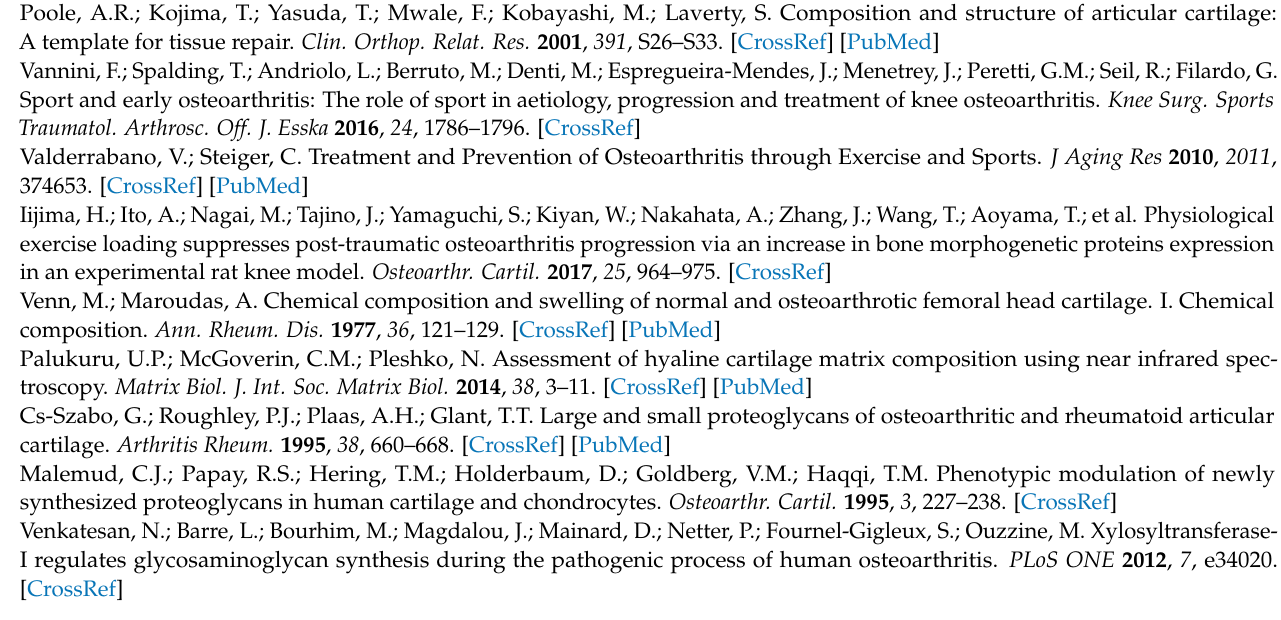
Table S2: Expression of selected genes related to heparan sulfate synthesis in WT and Ext1 gt/gt - engineered cartilage according to cDNA array analysis, Table S3: Expression of genes regulated >1.5-fold in WT cartilage in response to loading, Table S4: Expression of genes regulated >1.5-fold in Ext1 gt/gt cartilage in response to